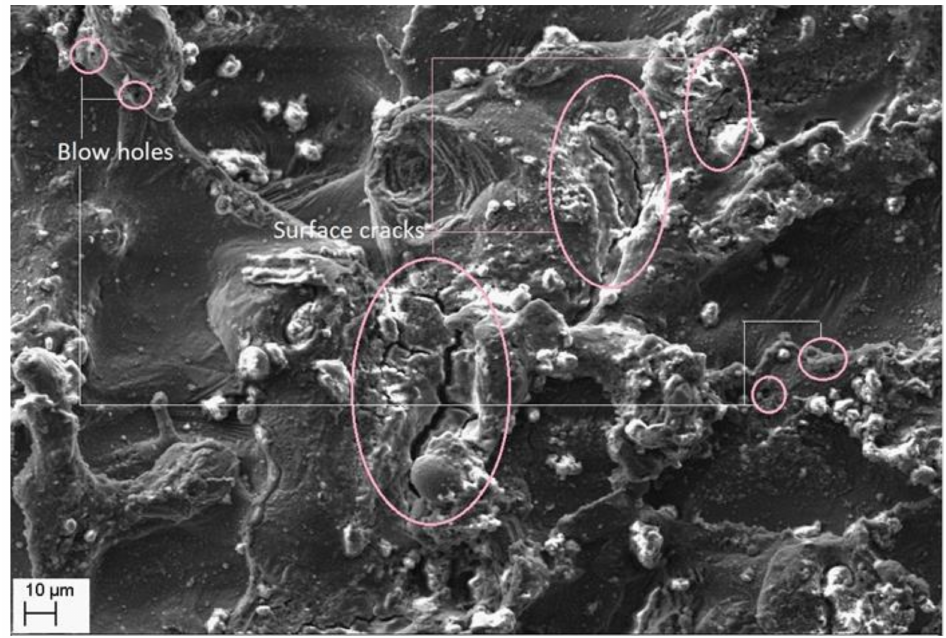
Figure 13. Cracks and voids on the recast